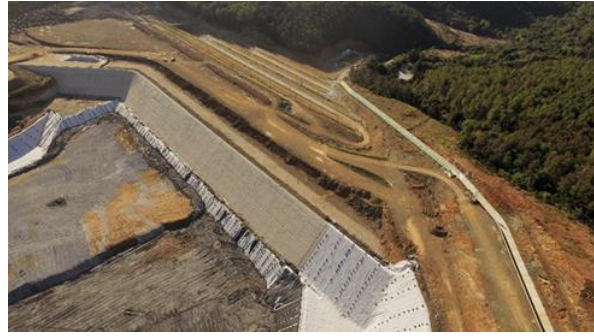
Figure 9. Downstream embankment